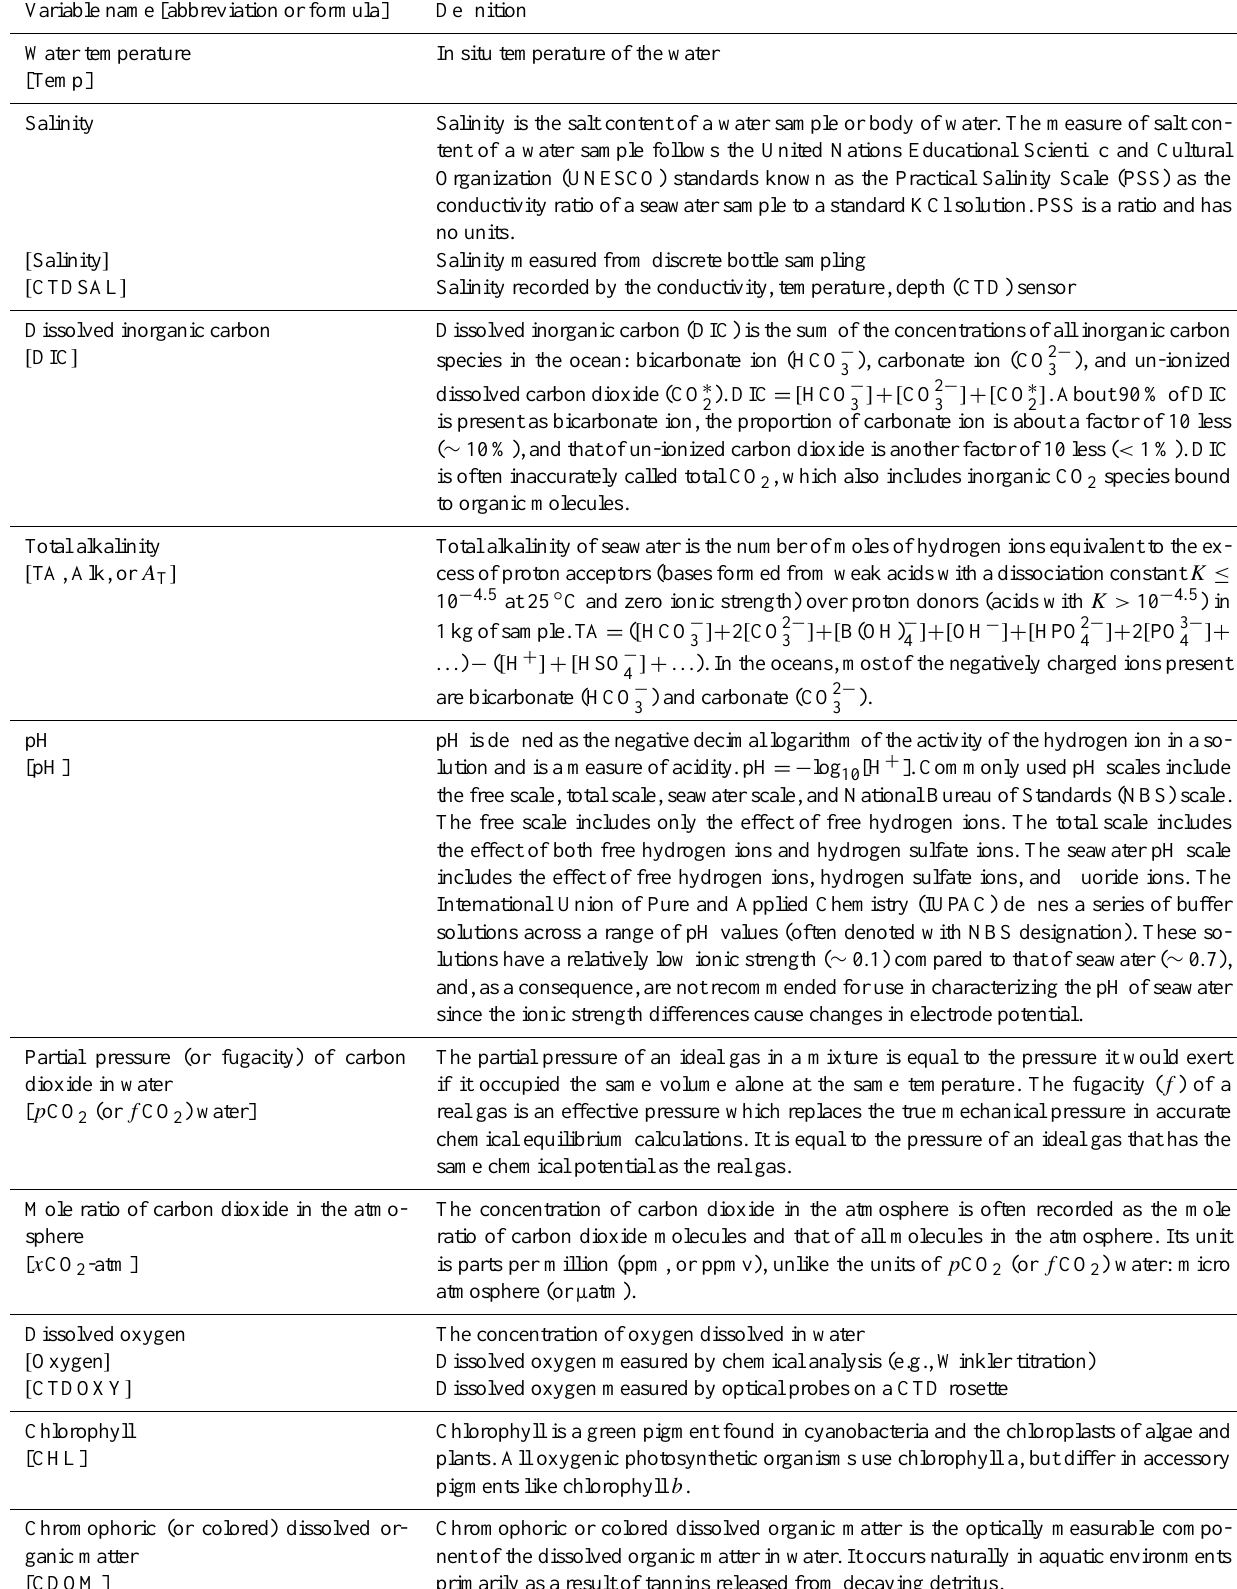
Table 1. Some commonly used ocean acidification variables, their definitions, and recommended